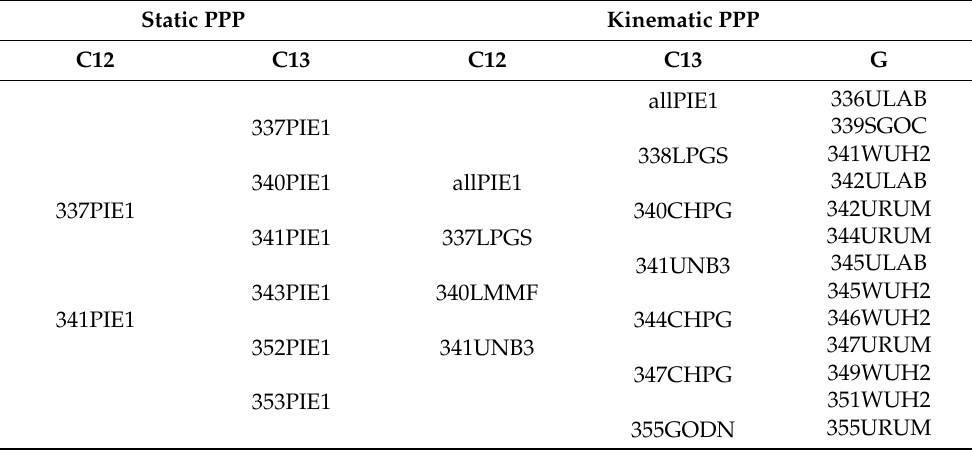
Table 2. Statistics of excluded sample